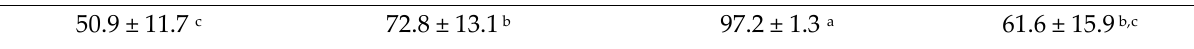
Figure 3. The photographs, histological structure, and extensive hair growth area of C3H/HeMlac mouse skin after topical application of DI-water as control, 2% minoxidil, and 1 mg/mL Sang-Yod (SY) and Mun-Poo (MP) red pigmented rice extracts. These agents were applied to 9-week-old C3H/HeMlac mice (male); 0.5 mL/day/mouse for 28 days; Hematoxylin and eosin histological section at 400× magnification with a 400 µm scale bar; Mean ± S.D. ( n = 2); Different superscript letters (a, b, c) indicate statistically different values (ANOVA, Duncan’s multiple range tests, p < 0.05).